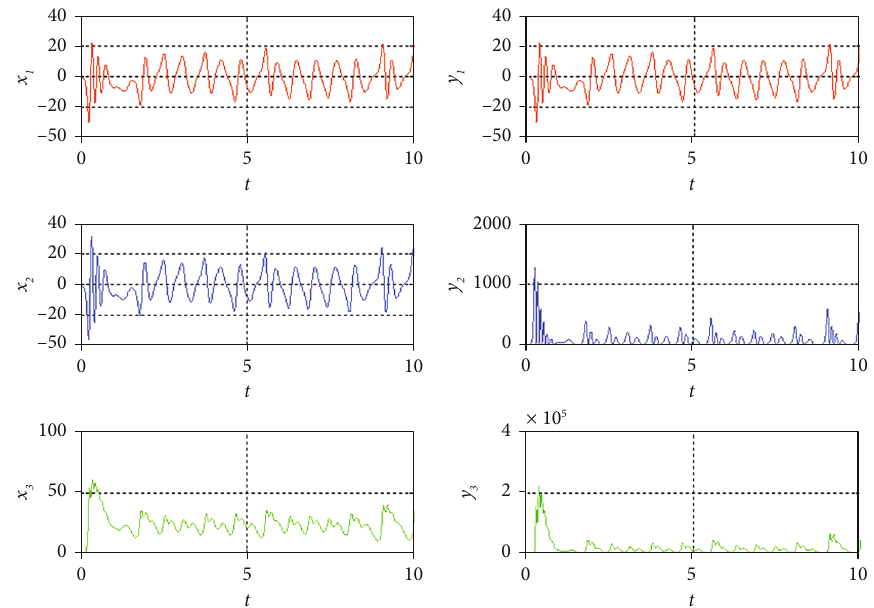
Figure 5: Time histories of di ff erent state variables in the unidirectionally coupled Chen system with the high-order polynomial manifold (cid:2) T . , x + x 2 , x 3 y = ½ x 1 2 2 3